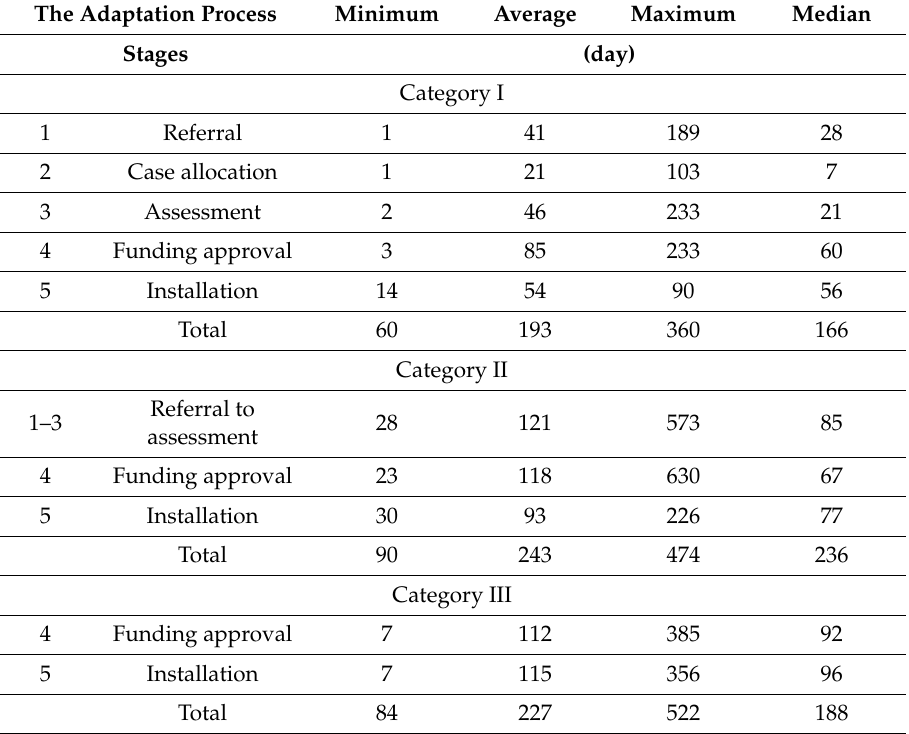
Table 1. Timelines between stages of the adaptation